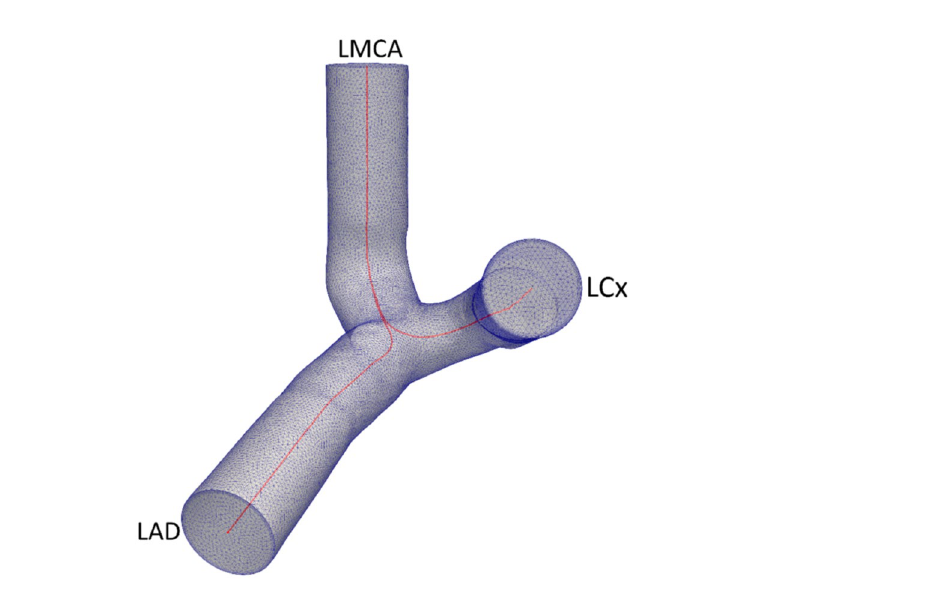
Figure 2. Computational dynamic mesh generated, with the vessel centerline shown in